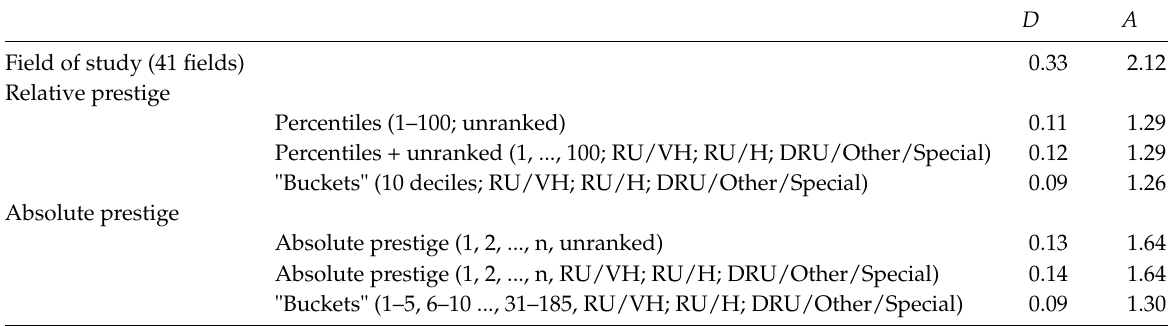
Table 1: Summary measures of gender segregation of U.S. doctorates by field and program